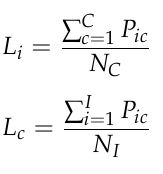
Figure 4a. In the proposed solution, the explainer analyzes the Q-function by calculating the contribution of every input feature to every reward